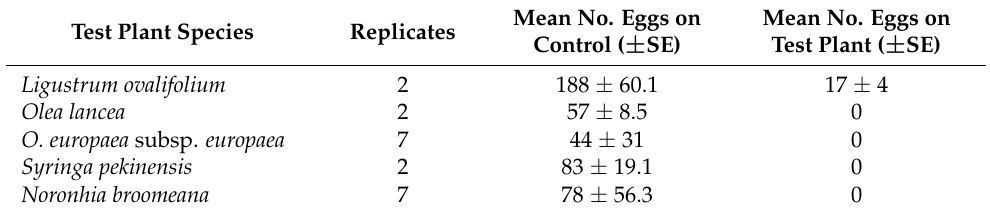
Table 5. The mean number of eggs per plant laid by adult Epiplema albida during preliminary single–choice oviposition (control Ligustrum robustum subsp. walkeri ).